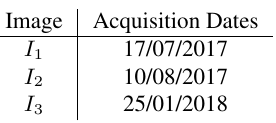
Table 1. Acquisition dates of Sentinel-1